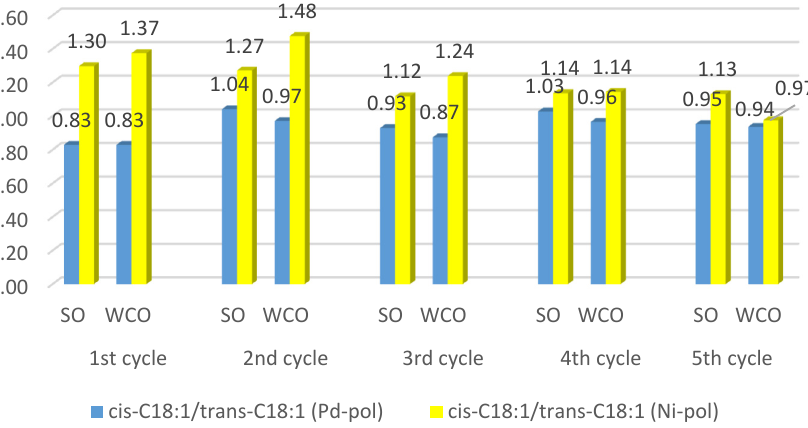
Figure 7. The cis- C18:1/ trans -C18:1 molar ratio in SO and WCO partially hydrogenated biodiesel over five subsequent cycles with Pd-pol and Ni-pol .